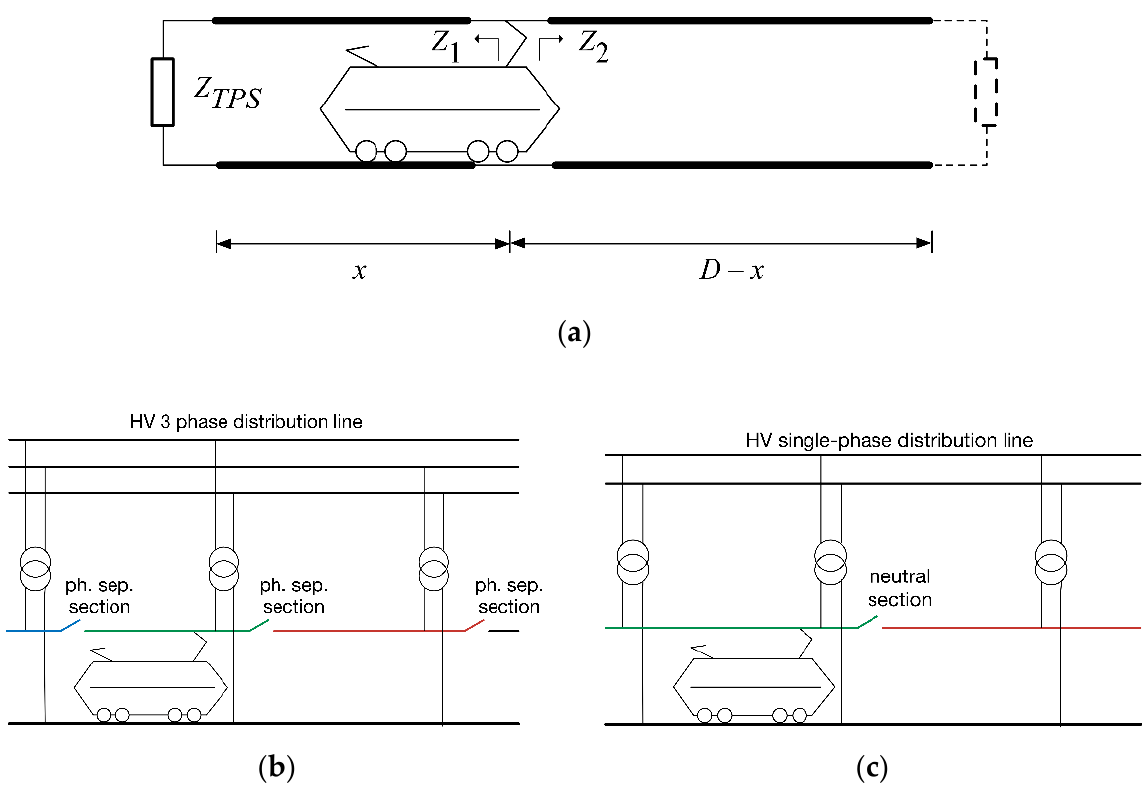
Figure 1. ( a ) Simplified equivalent circuit for the AC traction line seen at the pantograph port; ( b ) single-side supply scheme typical of 25 kV 50/60 Hz systems; ( c ) portion of an interconnected network typical of 15 kV 16.7 Hz systems. The frequency response of a railway line depends first of all on its length, and in particular on the length of the supply section, when this is electrically separated from